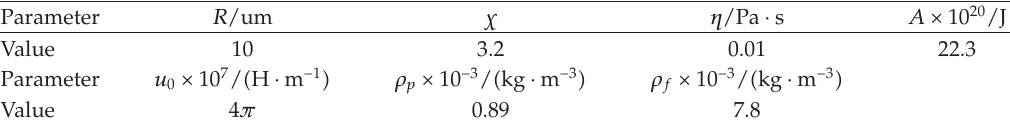
Table 1: The parameters of magnetorheological